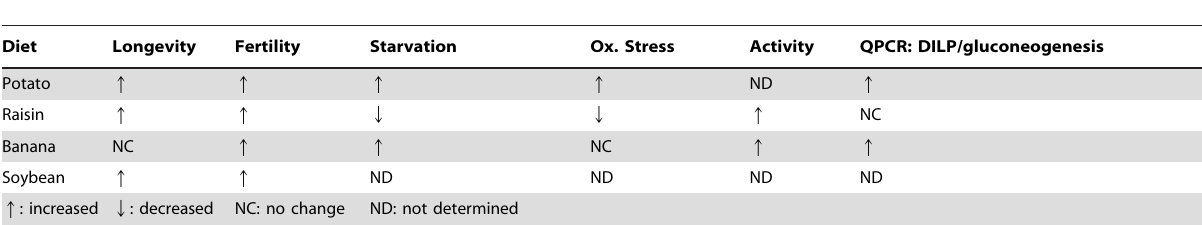
Table 1. Effects of organic diets on Drosophila health parameters compared to conventional diets.